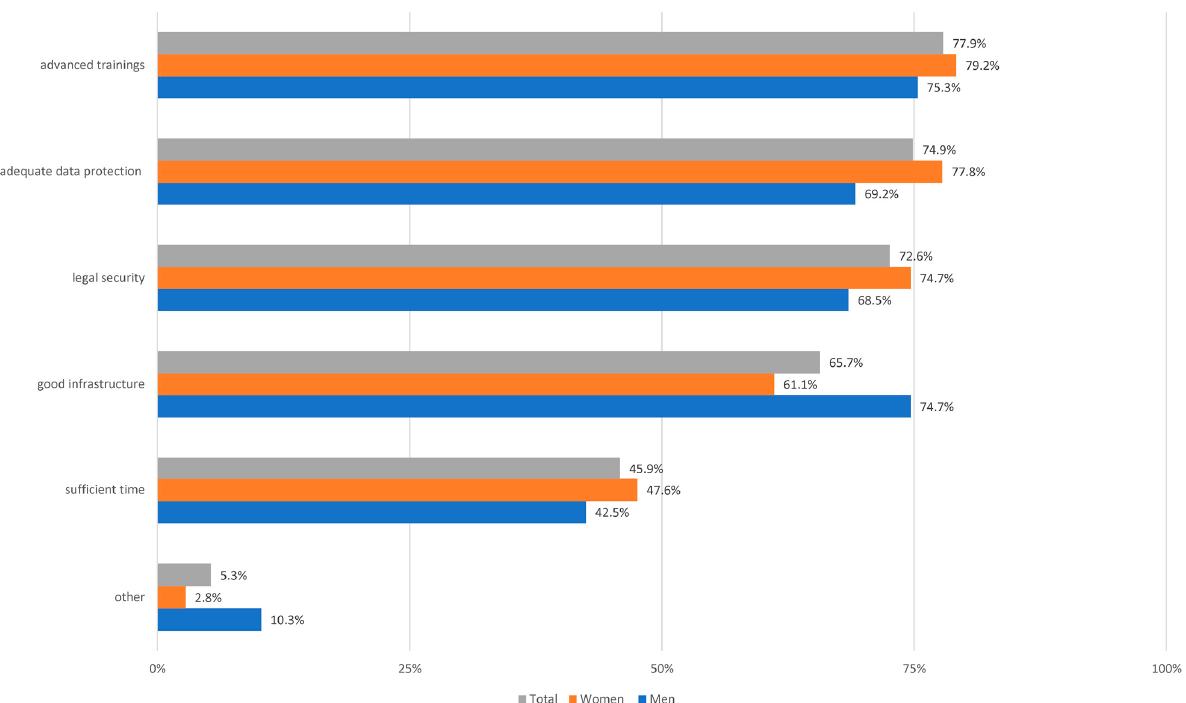
Figure 1. Description of the necessary prerequisites for physicians in the digitalization of medicine from the perspective of the study participants (multiple answers were possible; n = 434).